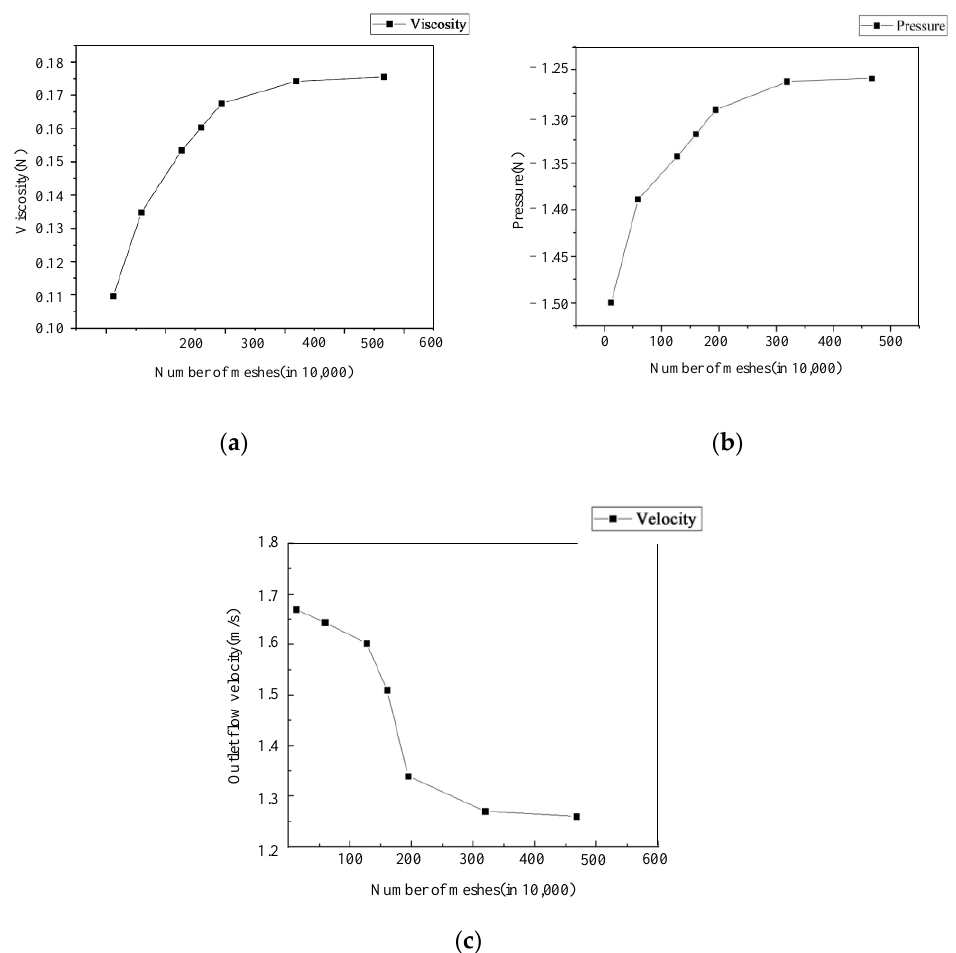
Figure 5. Mesh sensitivity analysis. ( a ) Viscosity versus number of meshes. ( b ) Pressure versus number of meshes. ( c ) Outlet flow velocity versus number of meshes.